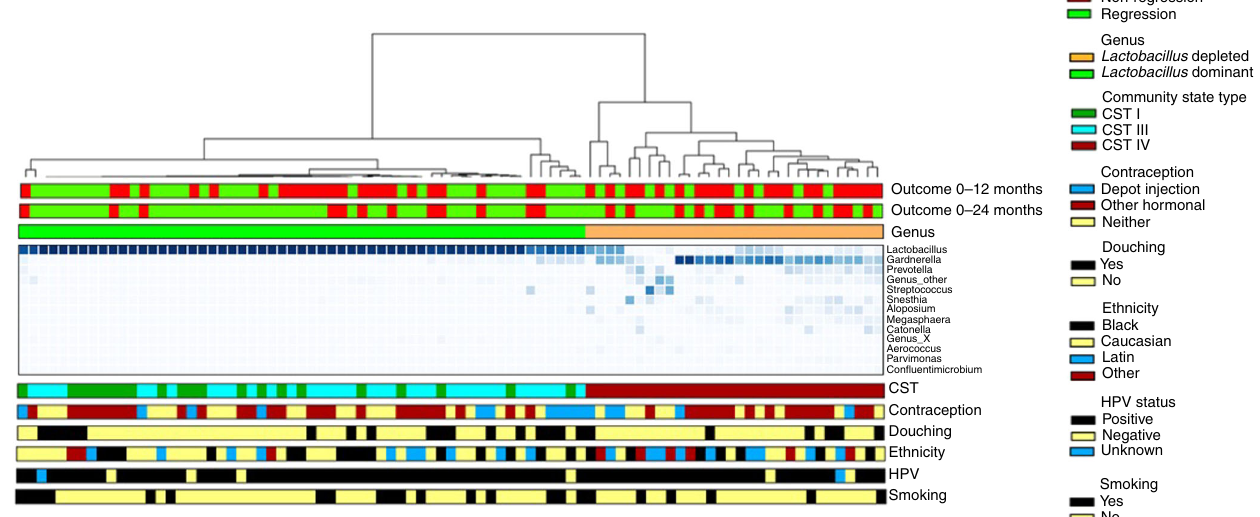
Fig. 2 Heatmap to show vaginal microbiota composition at baseline (time = 0) according to disease outcomes between 0 – 12 and 0 – 24 month follow- up. CST Community state type, CST I Lactobacillus crispatus- dominant, CST III Lactobacillus iners -dominant, CST IV Lactobacillus spp.-depleted, high diversity, HPV human papillomavirus, VMB vaginal microbiota. Top 20 taxa shown, and all remaining taxa denoted as ‘ other ’ .